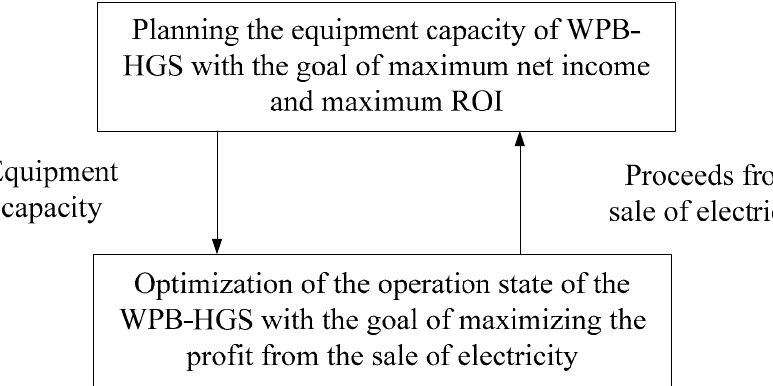
Figure 2. Bi-level planning